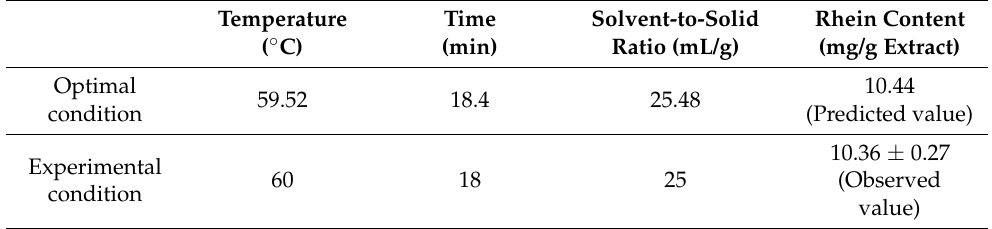
Table 7. Predicted and actual values for the verification of optimal extraction